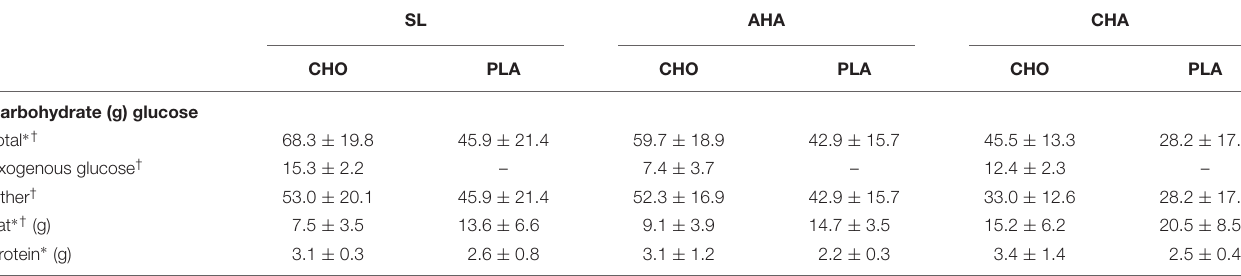
TABLE 4 | Total substrate oxidized during final 40 min of steady-state